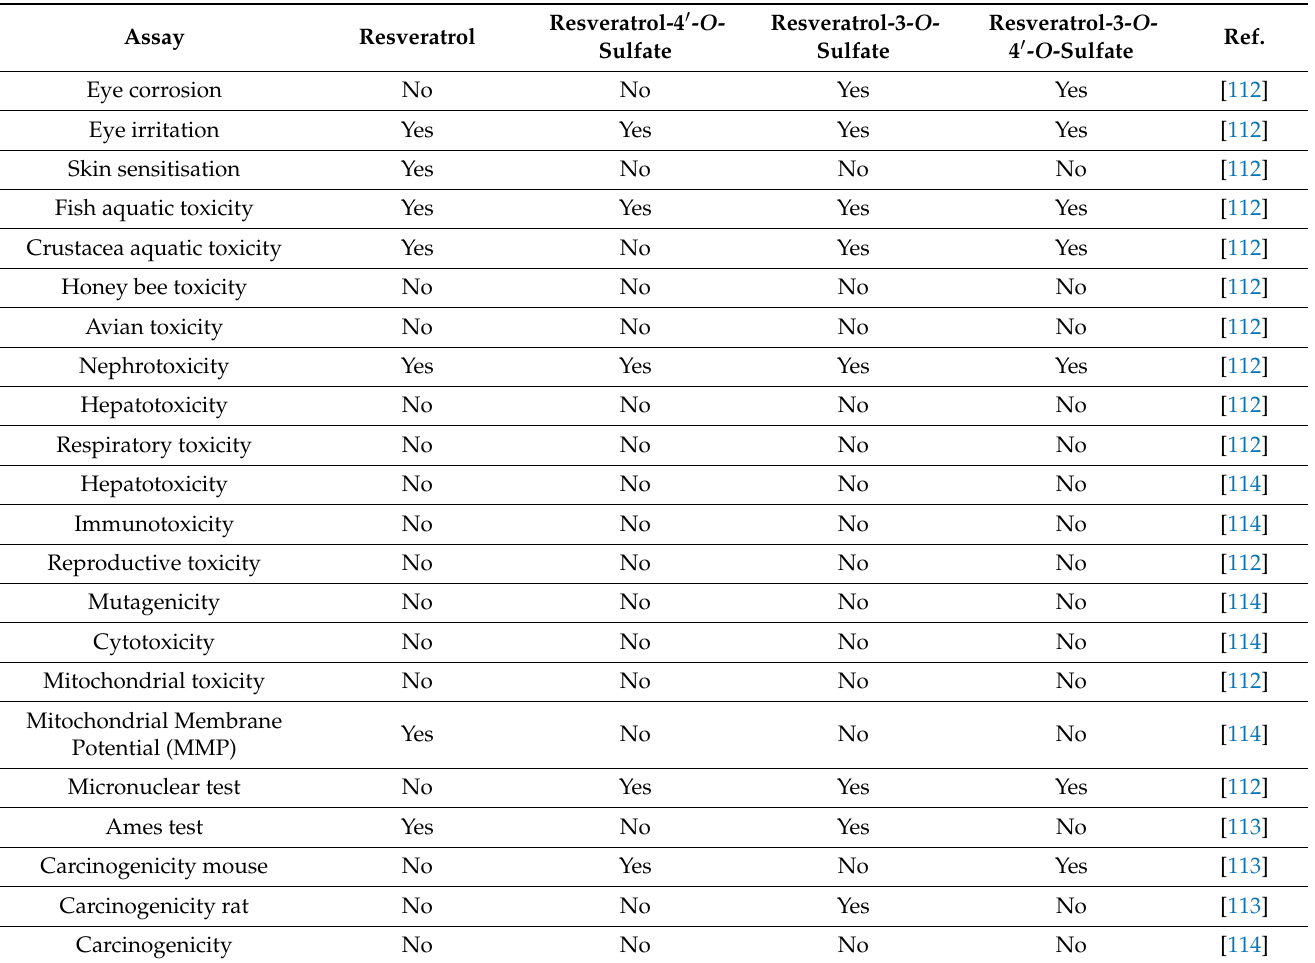
Table 3. The basic toxicological parameters of resveratrol and its sulfates are calculated using free web-based softwares [112–114]. References [113–115] correspond to admetSAR 2.0, PreADMET, and ProTox-II, respectively. Resveratrol-4 (cid:48) - O - Resveratrol-3- O - Resveratrol-3- O - Resveratrol Sulfate Sulfate 4 (cid:48) - O -Sulfate